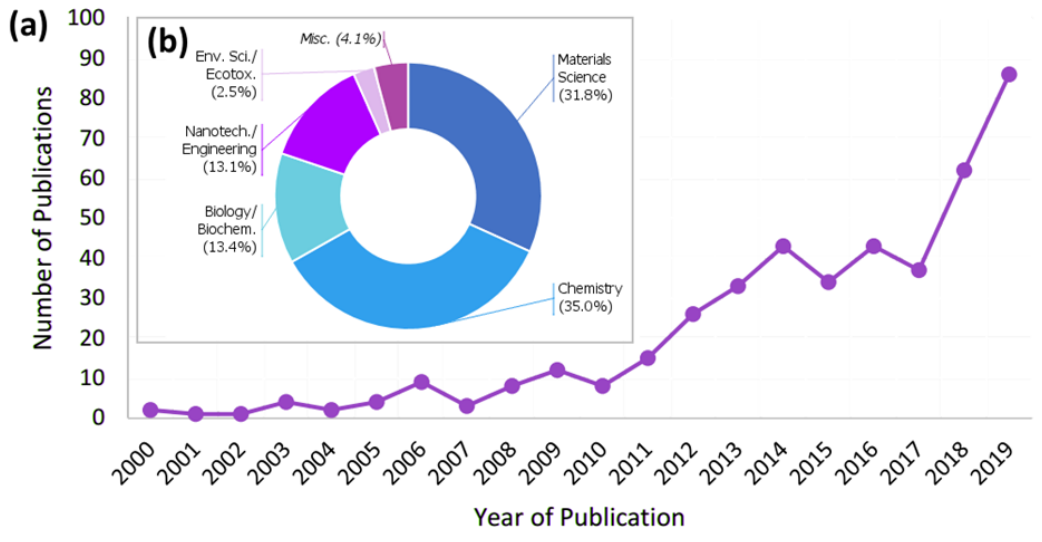
Figure 1. ( a ) An analysis of articles that feature biomimetic or bioinspired antifouling research published per year for the years 2000 until end of 2019 and ( b ) breakdown of source journals by primary field. The search was conducted in April 2020 using both SCOPUS and Web of Science, with the criteria “(biomim * OR bioinsp *) AND (antifoul * OR biofoul *)”. This search shows the increase in the number of publications on biomimetics and antifouling research from a low baseline in 2000 to a greater publication rate in recent years, with almost half of all results returned having been published in